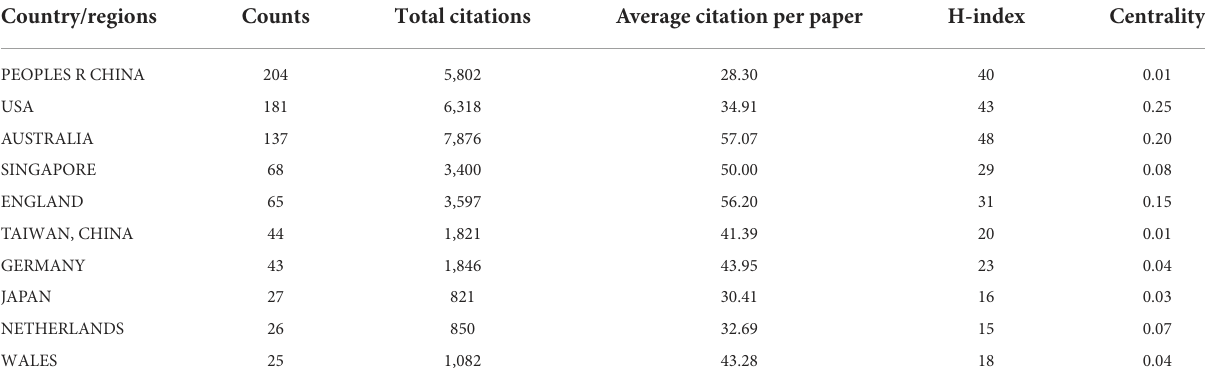
TABLE 1 Top 10 countries/regions with the most publications from 2006 to 2021.